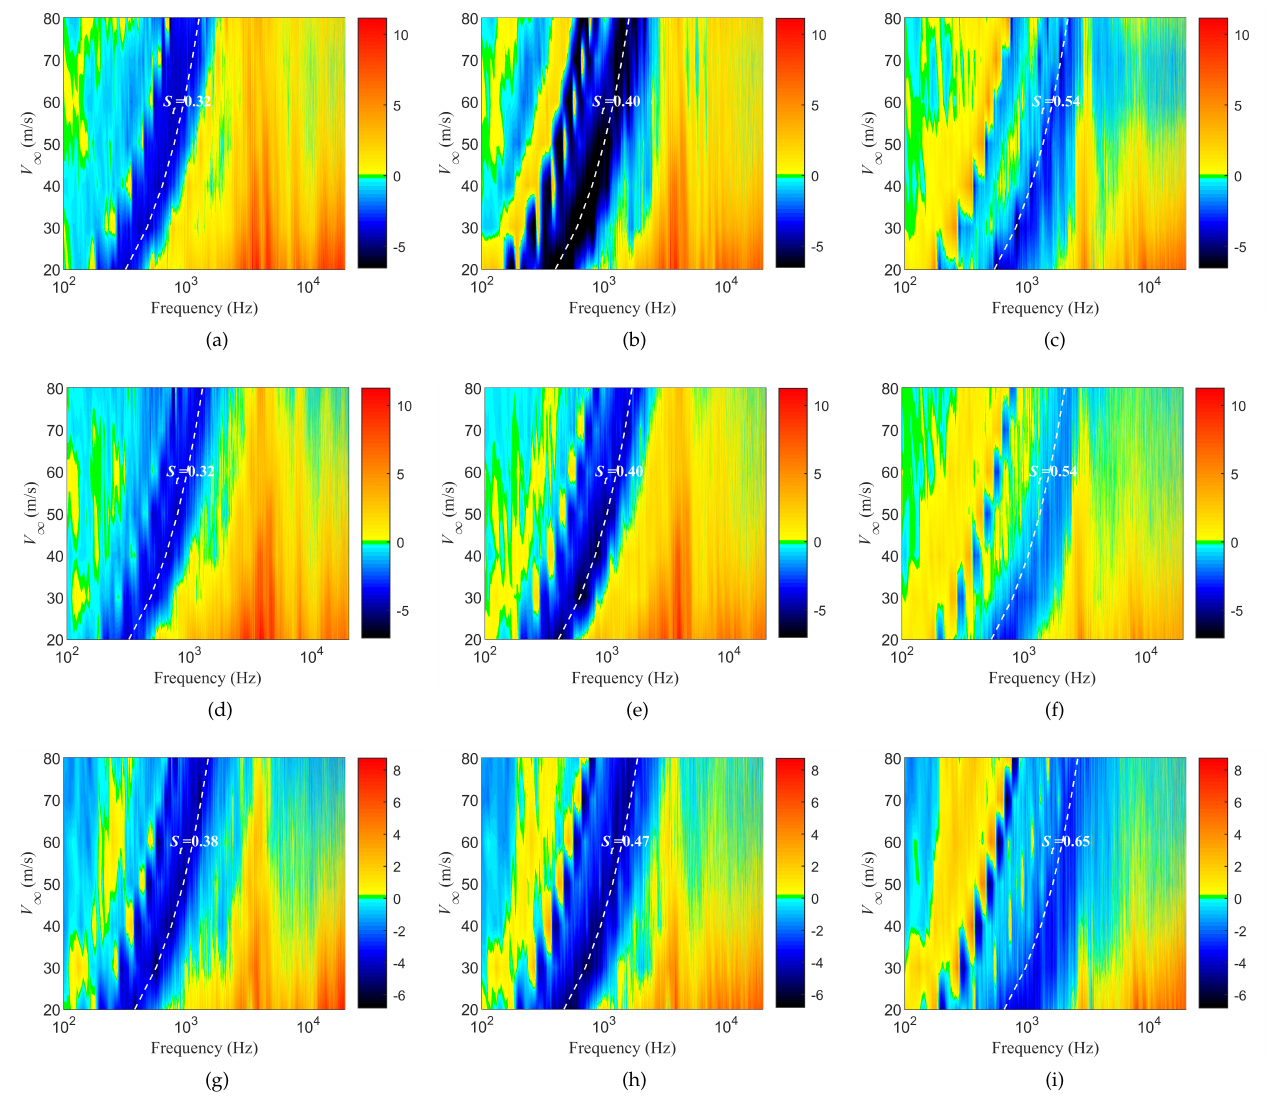
Figure 10. ∆ SPL for different porous positions: ( a ) X00Y00Z40, L = 100 mm, α = 0 ◦ ; ( b ) X00Y40Z00, L = 100 mm, α = 0 ◦ ; ( c ) X40Y00Z00, L = 100 mm, α = 0 ◦ ; d ) X00Y00Z40, L = 200 mm, α = 0 ◦ ; ( e ) X00Y40Z00, L = 200 mm, α = 0 ◦ ; ( f ) X40Y00Z00, L = 200 mm, α = 0 ◦ ; g ) X00Y00Z40, L = 200 mm,